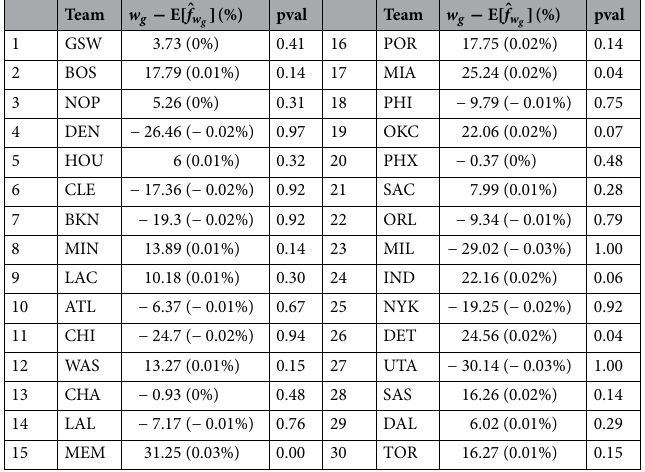
Table 4. Net whistle gain for different